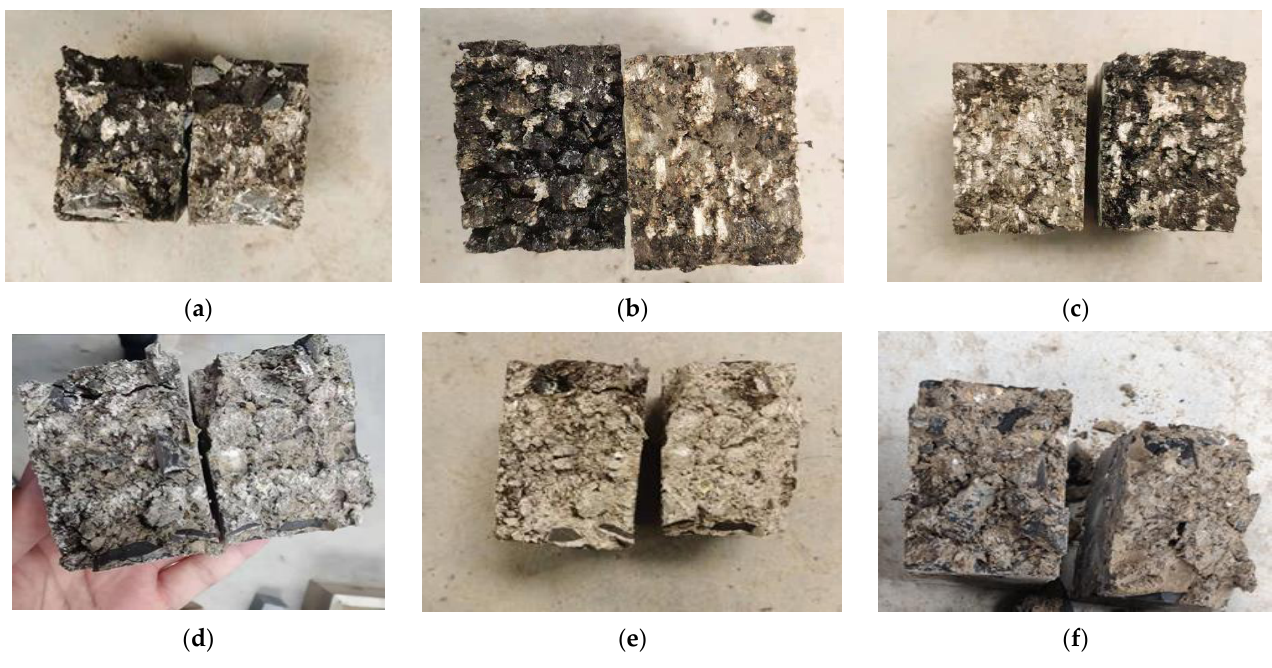
Figure 7. Shear failure form of specimens without interlaminar treatment. ( a ) I-1; ( b ) I-2; ( c ) I-3; ( d ) I-5; ( e ) I-6; ( f ) I-7.